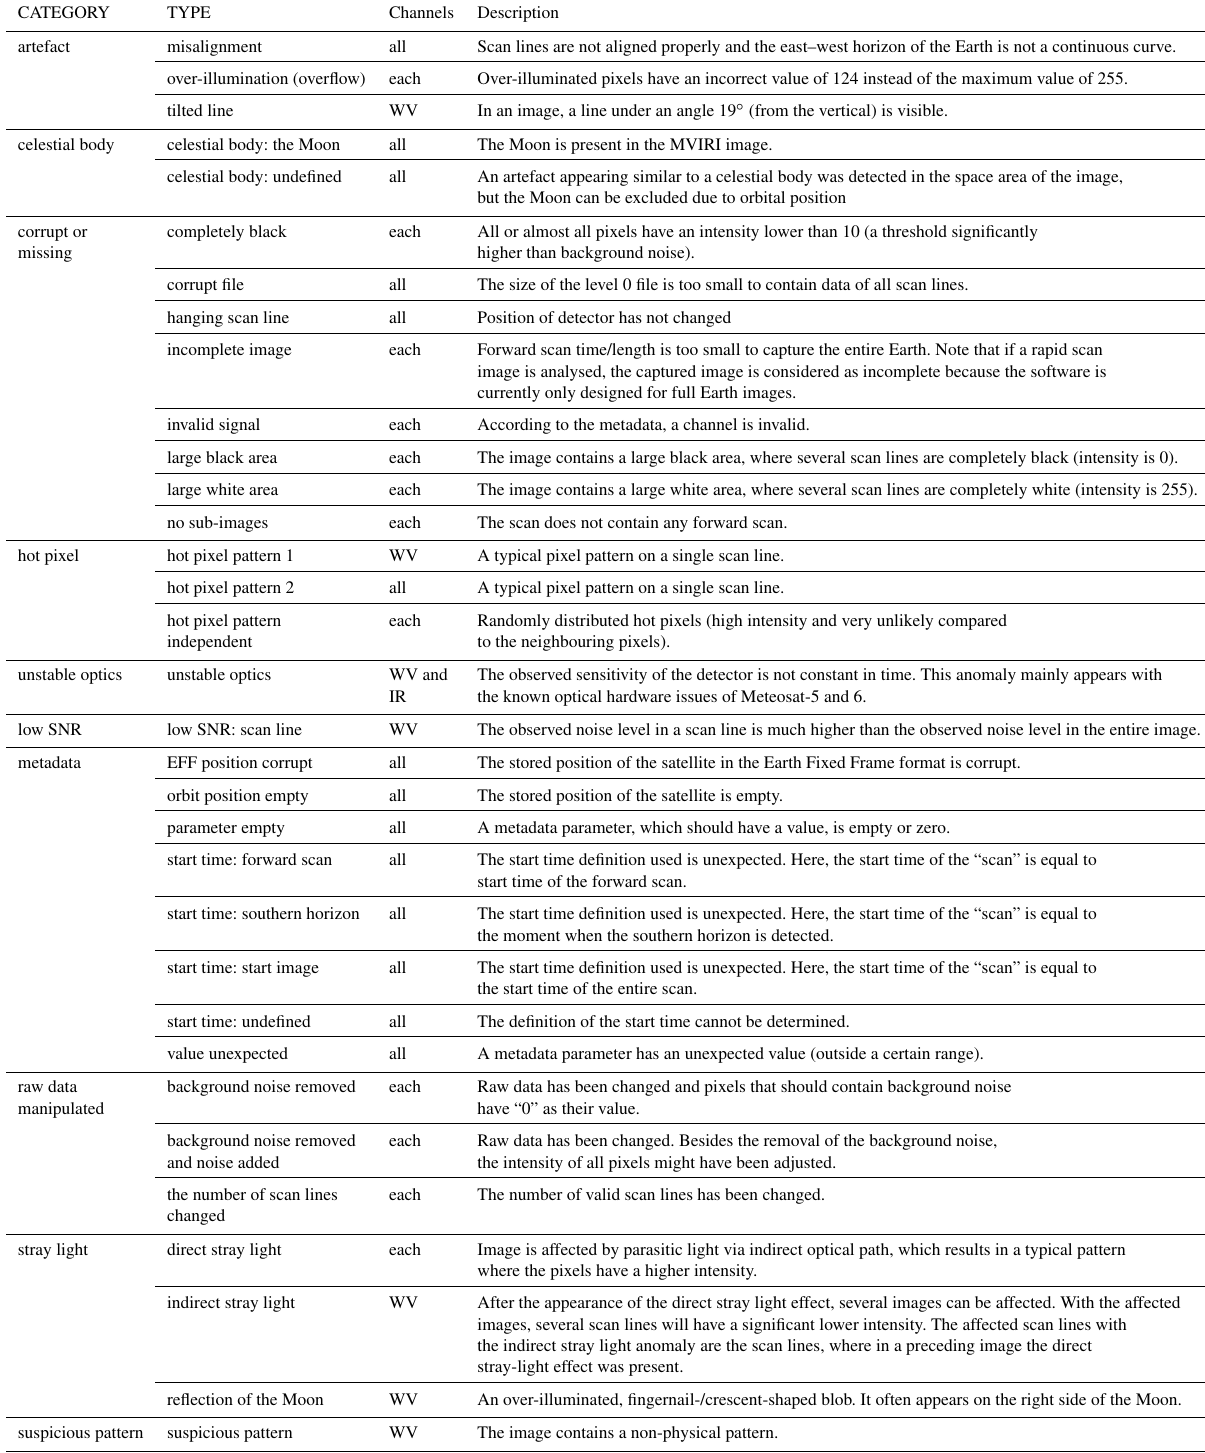
Table 3. Description of the defined anomaly types in the MFG measurement and the affected channels. For the channels, all means the anomaly affects all channels simultaneously, whereas each means that each channel is analysed individually.